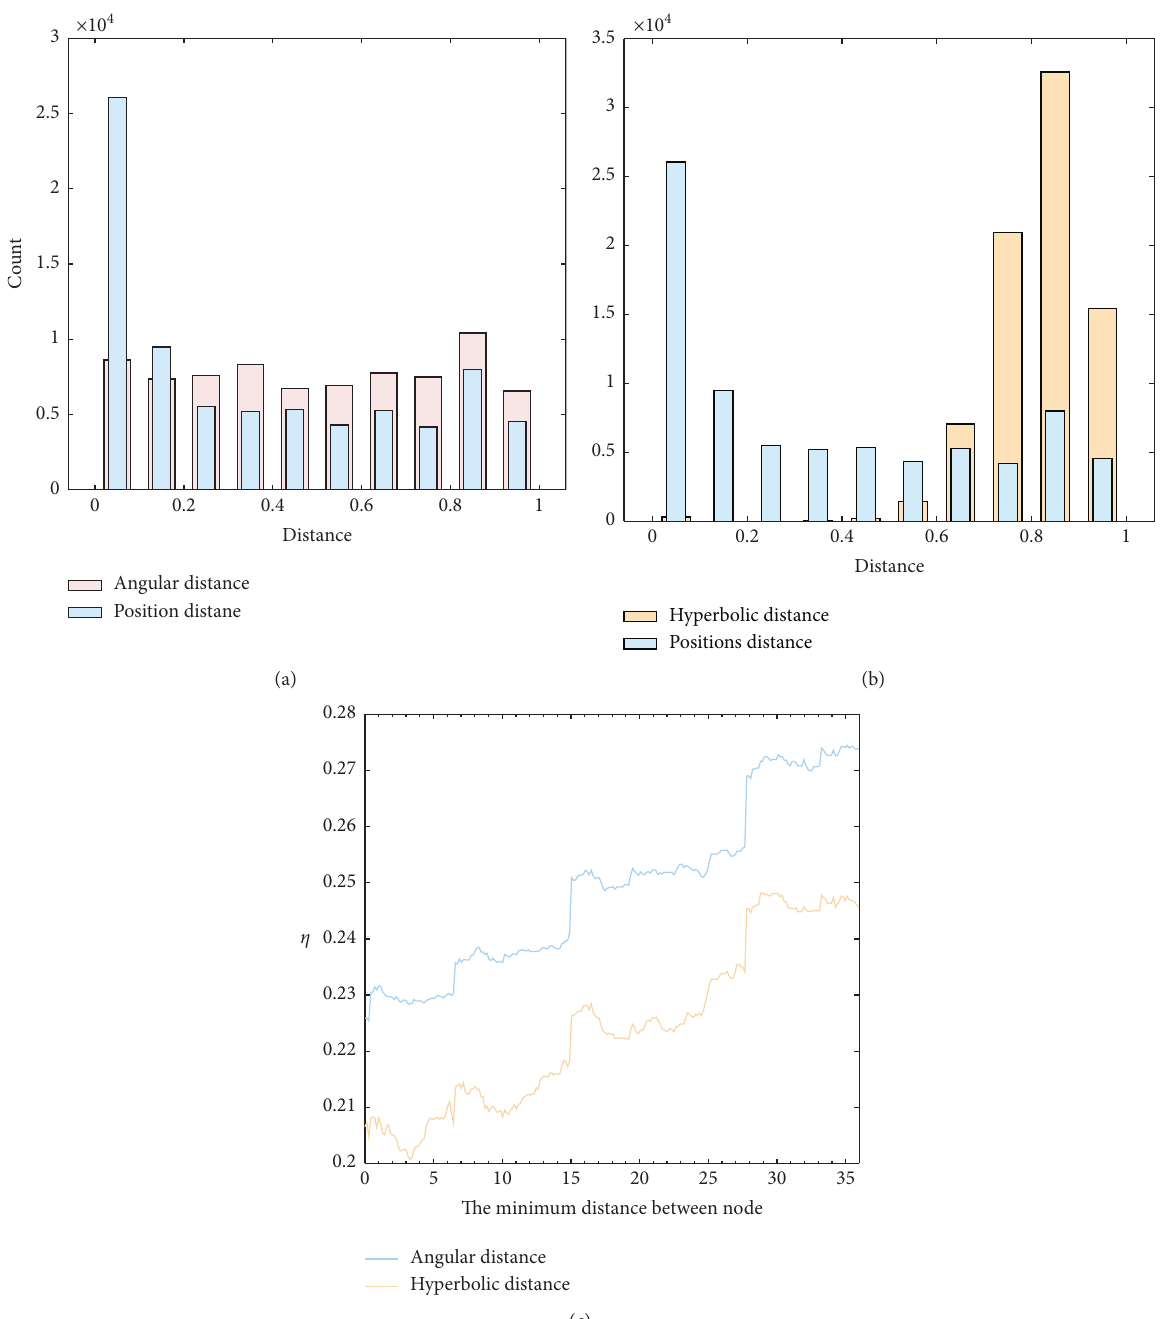
Figure 5: The result of mapping the C elegans neural network in hyperbolic space. (a, b) The relationships among the hyperbolic distance, the angular distance, and the spatial distance. The abscissa indicates the distance between the nodes, and the ordinate is the statistic for the number of distances. (c) The value of η according to the starting point of different partitions, which is used to find the optimal disc partitioning result of η . The blue and pink lines represent the results of η , which are calculated from the angular distance and the hyperbolic distance,